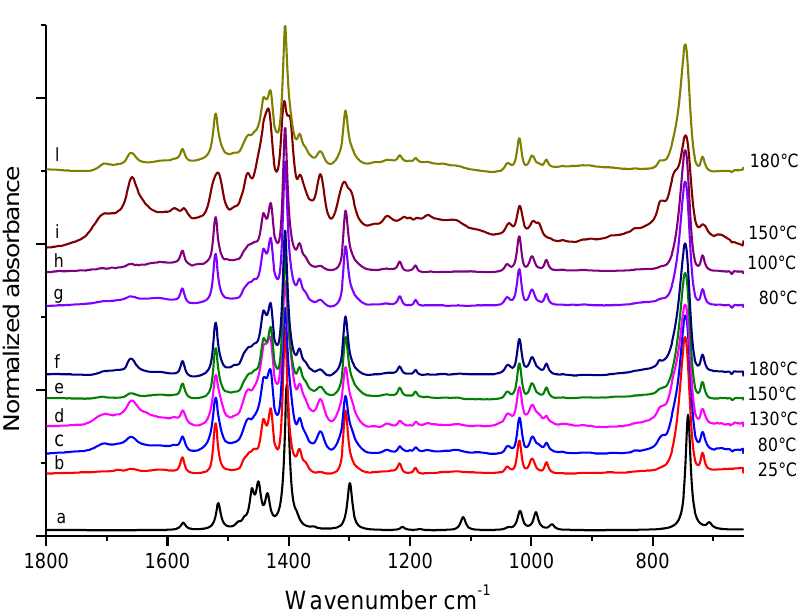
Figure 2. FT-IR spectra, in the 1800–700 cm −1 region, of TMP samples heated in air at different temperatures. On the right side of the Figure, treatment temperatures ( ◦ C) are indicated. ( a ): theoretical DFT spectrum of TMP. ( b ): pristine TMP; ( c )–( f ): samples treated in the absence of HSAG. ( g )–( l ): samples treated in the presence of catalytic amount of HSAG. All the spectra were obtained immediately after drop deposition on ZnSe window, from the collection of the first few scans. Table 1. Values of the wavenumbers corresponding to the absorption peaks of the most intense IR transitions: comparison between experimental and computed values (B3LYP/6-311++G(d,p)). Vibrational assignments are based on computed eigenvectors